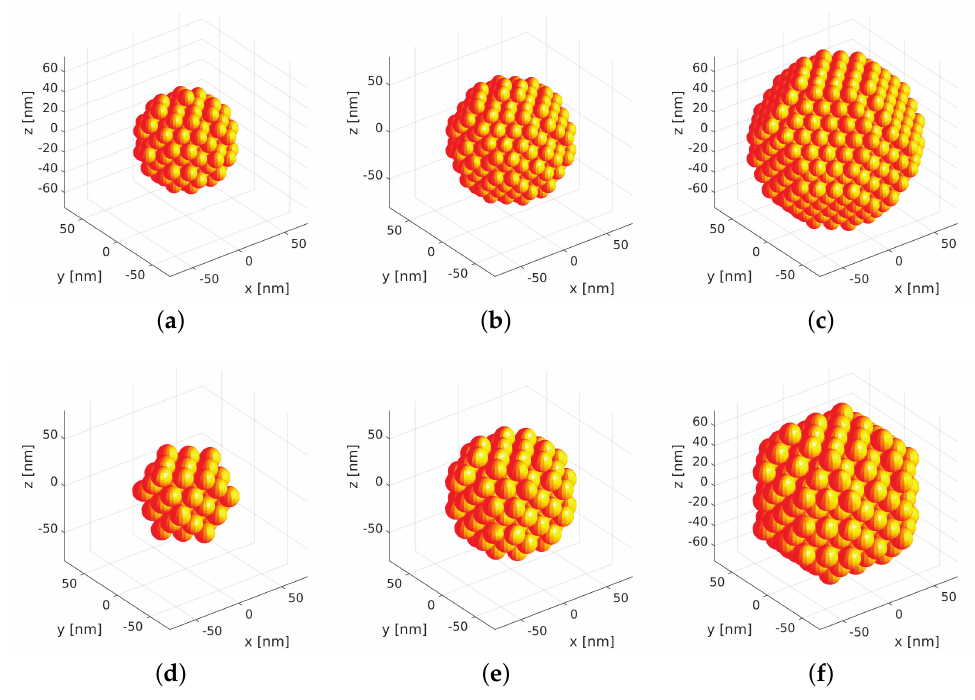
Figure 4. ( a – f ) Spherical particle geometries, described by parameters listed in Table 1.